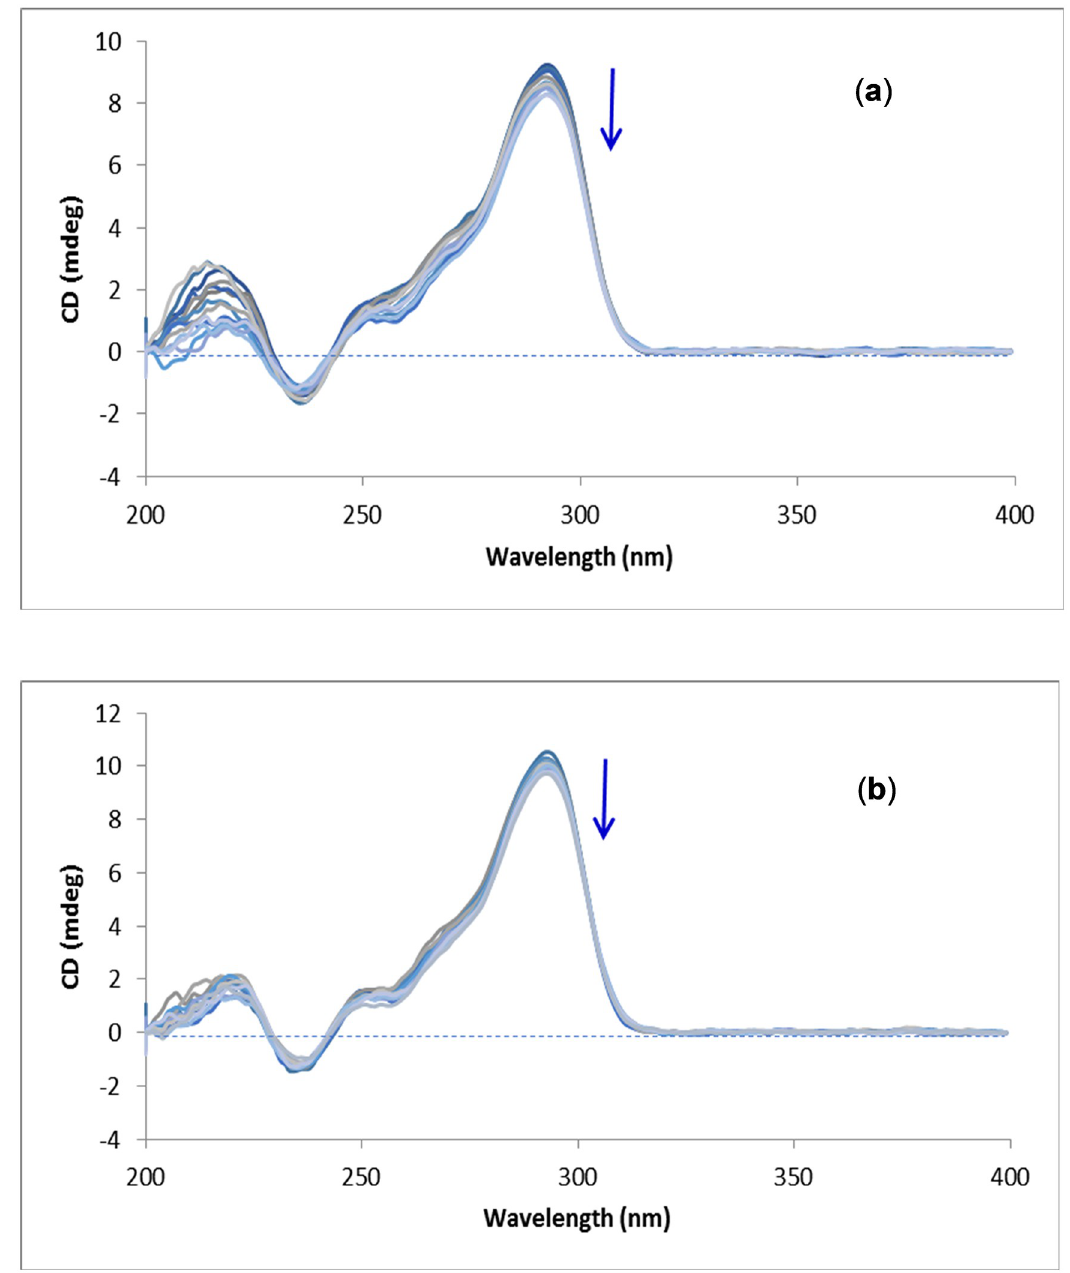
Fig 3. CD titration of human telomeric G-quadruplex DNA (1 × 10 − 5 M) with 1 × 10 − 4 M of GW-2974 (a) and SCH-442416 (b) in Tris–KCl buffer (pH 7.4).